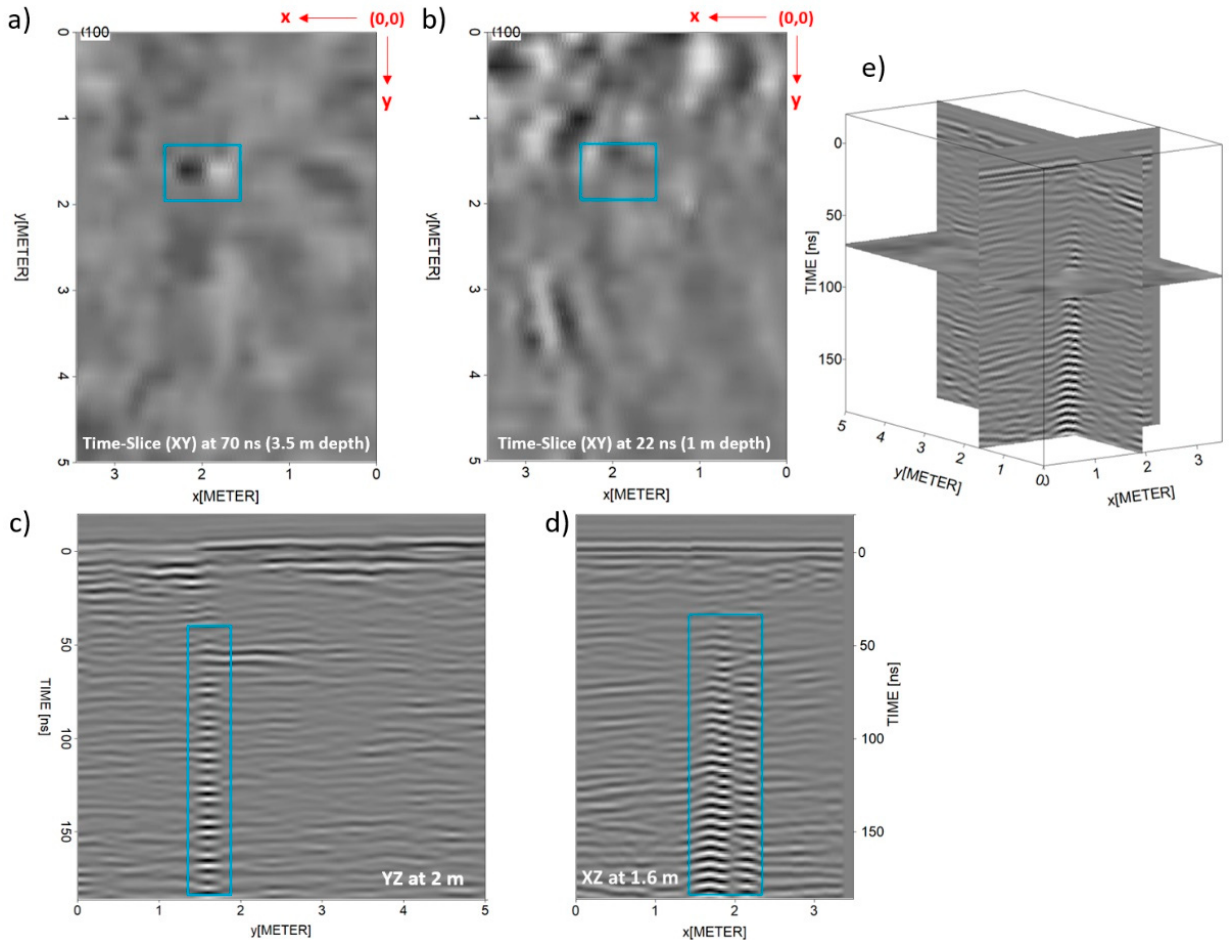
Figure 5. 200 MHz data: time-slice or XY image at 3.5 m depth ( a ), time-slice at 1 m depth ( b ), YZ image at 2 m in x -line ( c ), XZ or conventional radargram at 1.6 m in y -line ( d ), and 3D perspective ( e ).